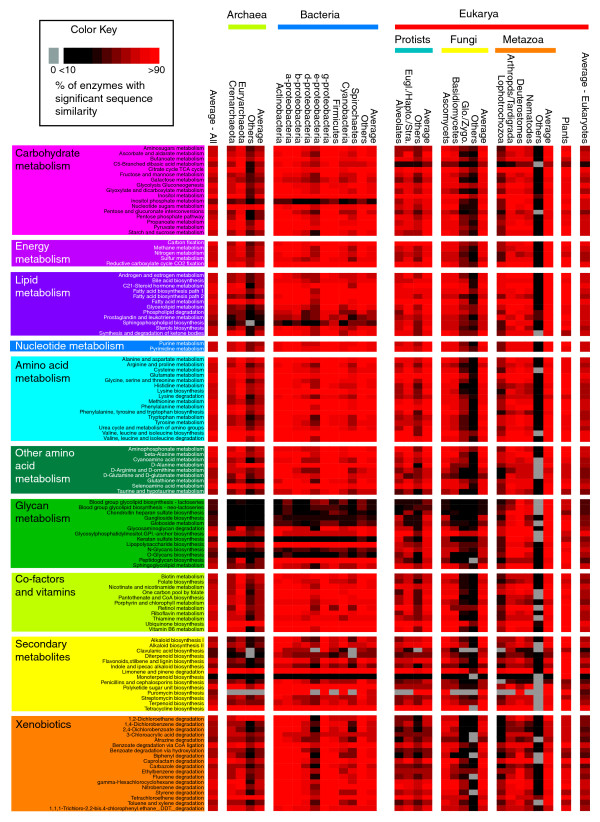
Heatmap showing the conservation of individual metabolic pathways. Each row indicates an individual metabolic pathway grouped by their superclass membership (defined by KEGG). Each column indicates specific taxonomic divisions (see Materials and methods; Table 1). Colored tiles indicate the level of conservation (percentage of enzymes detected) of each pathway within each taxonomic group (see inset color key top left). For example, many Glycan metabolic pathways are poorly conserved with the exception of several groups of metazoans.